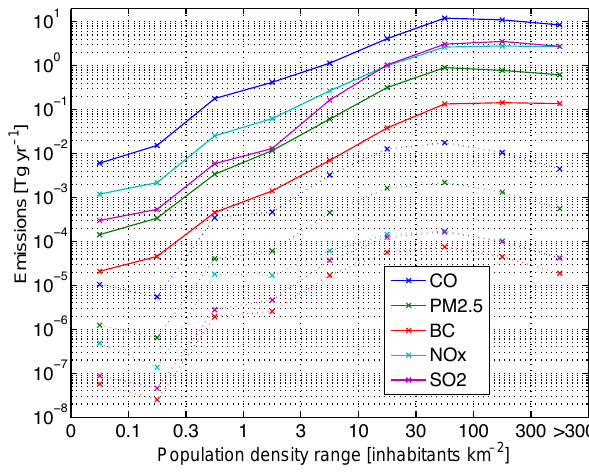
Figure 1. Current anthropogenic (solid lines) and wildfire emissions (dashed lines) for Europe by range of population density for vari- ous pollutants. Anthropogenic emissions are for 2010 and wildfire emissions average